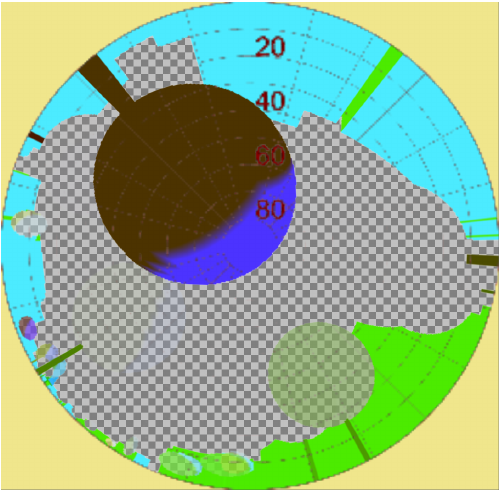
Figure 1. Fisheye image showing the upper hemisphere with trees and buildings as generated by the SkyHelios model in production mode. The colors and opacity correspond to different shortwave albedo, longwave emissivity, direct radiation factor of the surfaces (including direct shortwave reflections). The checkerboard background was added to visualize the objects